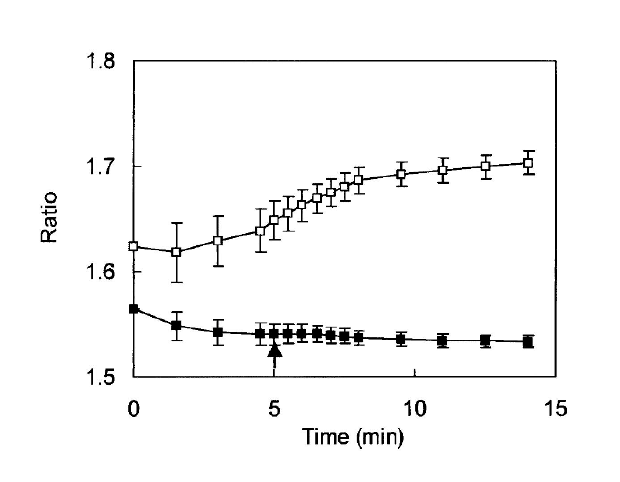
Figure 5 Changes of [Ca 2+ ] i level in primmorphs (aggregates of dissociated cells) from the sponge Suberites domuncula following ethylene treatment. S. domuncula cells were kept either in Ca 2+ - and Mg 2+ -free artificial seawa- ter (CMFSW) ( (cid:5) ) or in Ca 2+ - and Mg 2+ -containing seawater (SW) ( (cid:3) ). The cells were treated with 1 mM ethephon 5 min after starting the experiment. The values for the ratios of the 340/380 nm images are shown. The arrow marks the time at which ethephon was added to the cells. The results are expressed as mean values ± S.E.; n =